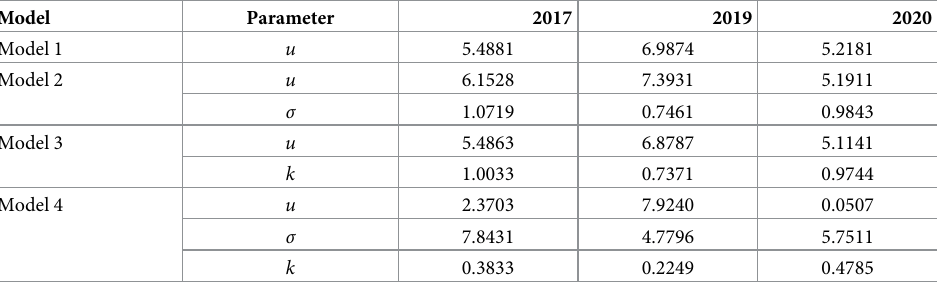
Table 4. Values of the adjusted parameters for each model in the experiments.